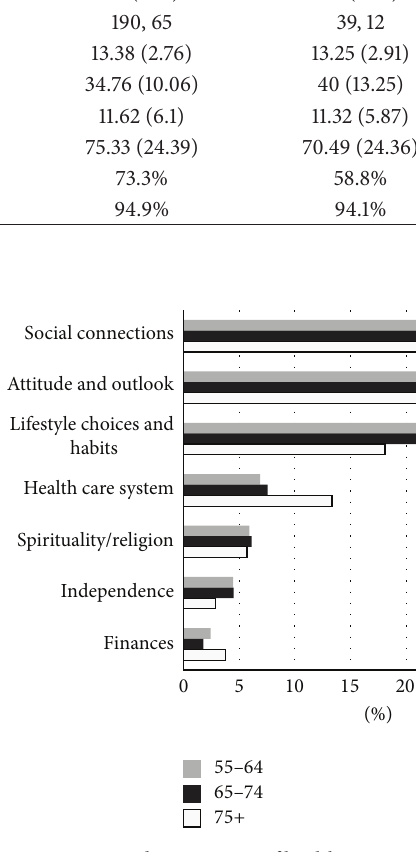
Figure 1: Seven determinants of healthy aging with MS. The average frequency of each theme by age